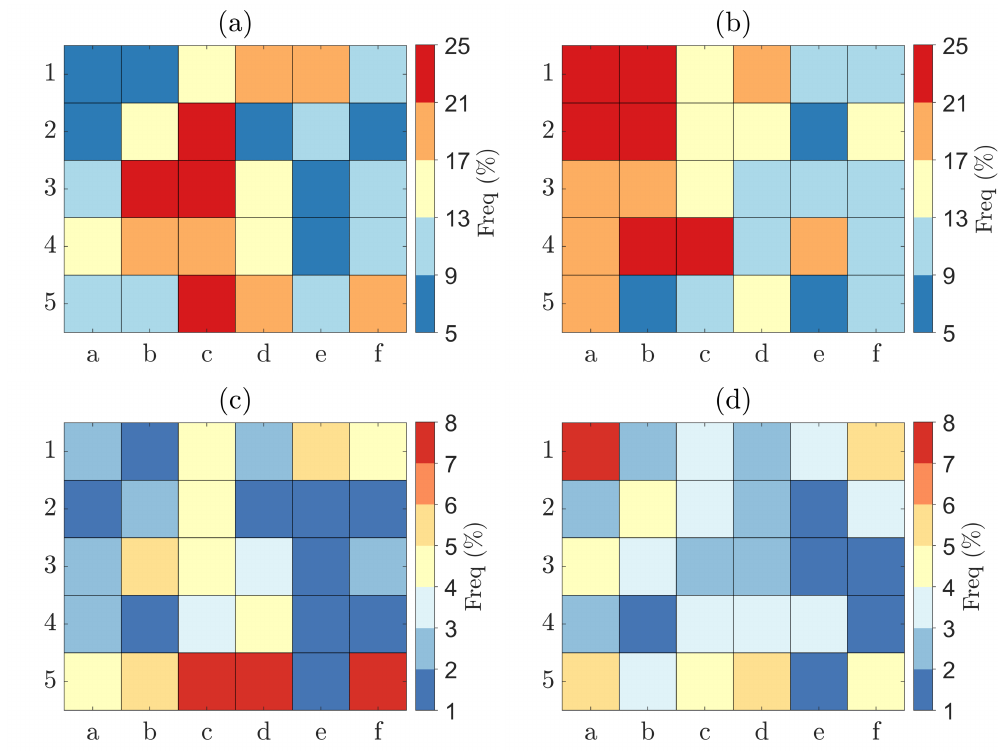
Figure 7. Frequency of ramp up and ramp down events as a function of weather pattern: ( a ) ramp up events as a fraction of the number of hours of generation classified as a particular pattern, ( b ) as ( a ) for ramp down events, ( c ) ramp up events as a fraction of the total number of ramps identified, and ( d ) as ( c ) for ramp down